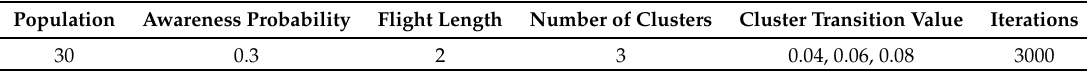
Table 4. CSA Parameters for SCP and